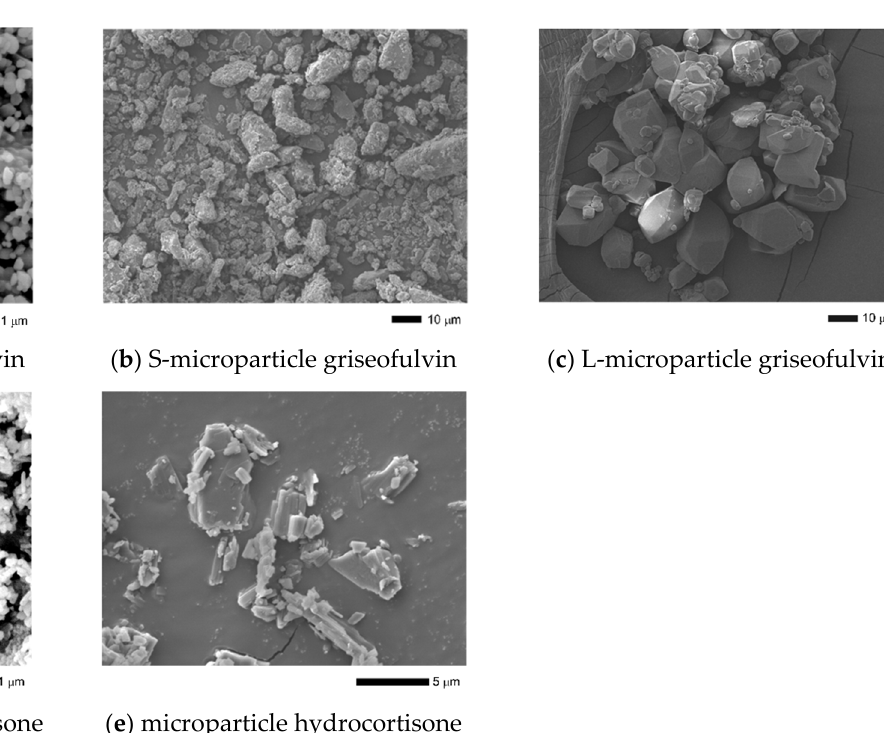
Figure 3. Scanning electron microscopy (SEM) image of griseofulvin samples ( a – c ) and hydrocorti- sone samples ( d , e ).